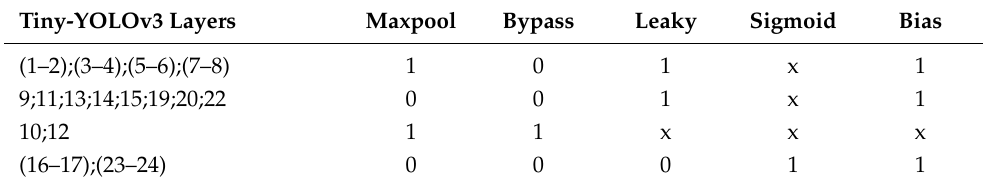
Table 3. Custom core configurations for Tiny-YOLOv3